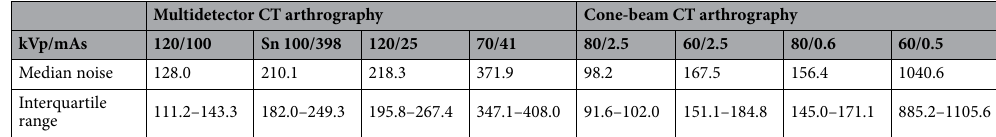
Table 4. Quantitative image quality comparison. Image noise quantification for multidetector CT (MDCT) and cone-beam CT (CBCT)